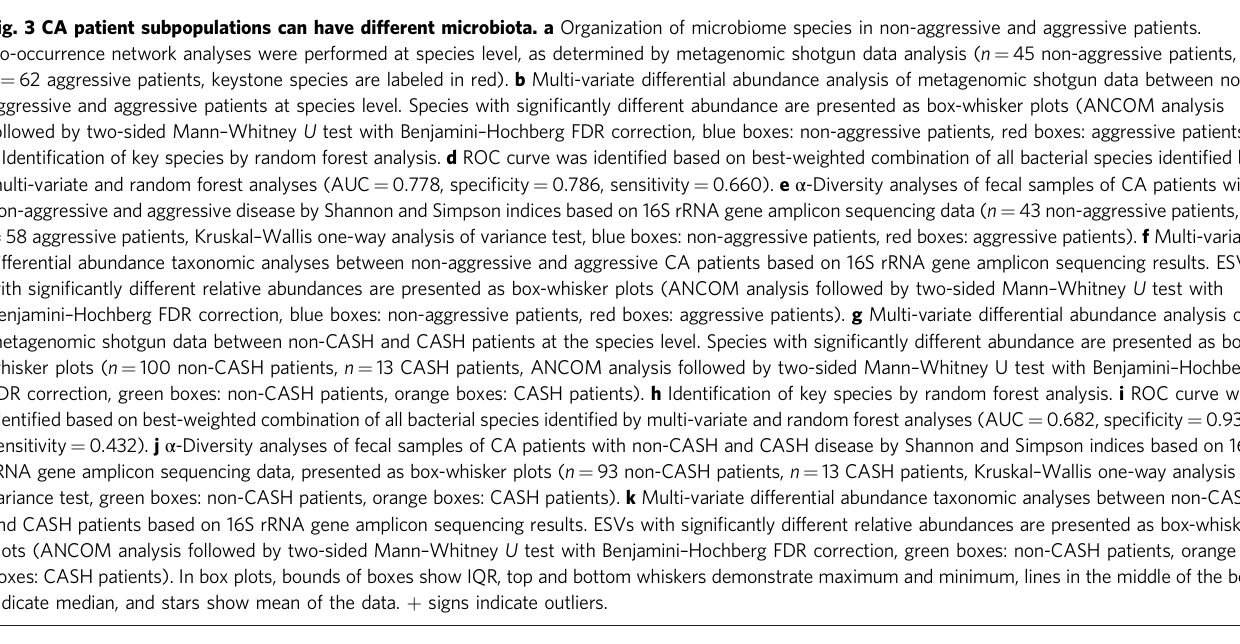
Fig. 3 CA patient subpopulations can have different microbiota. a Organization of microbiome species in non-aggressive and aggressive patients. Co-occurrence network analyses were performed at species level, as determined by metagenomic shotgun data analysis ( n = 45 non-aggressive patients, n = 62 aggressive patients, keystone species are labeled in red). b Multi-variate differential abundance analysis of metagenomic shotgun data between non- aggressive and aggressive patients at species level. Species with signi fi cantly different abundance are presented as box-whisker plots (ANCOM analysis followed by two-sided Mann – Whitney U test with Benjamini – Hochberg FDR correction, blue boxes: non-aggressive patients, red boxes: aggressive patients). c Identi fi cation of key species by random forest analysis. d ROC curve was identi fi ed based on best-weighted combination of all bacterial species identi fi ed by multi-variate and random forest analyses (AUC = 0.778, speci fi city = 0.786, sensitivity = 0.660). e α -Diversity analyses of fecal samples of CA patients with non-aggressive and aggressive disease by Shannon and Simpson indices based on 16S rRNA gene amplicon sequencing data ( n = 43 non-aggressive patients, n = 58 aggressive patients, Kruskal – Wallis one-way analysis of variance test, blue boxes: non-aggressive patients, red boxes: aggressive patients). f Multi-variate differential abundance taxonomic analyses between non-aggressive and aggressive CA patients based on 16S rRNA gene amplicon sequencing results. ESVs with signi fi cantly different relative abundances are presented as box-whisker plots (ANCOM analysis followed by two-sided Mann – Whitney U test with Benjamini – Hochberg FDR correction, blue boxes: non-aggressive patients, red boxes: aggressive patients). g Multi-variate differential abundance analysis of metagenomic shotgun data between non-CASH and CASH patients at the species level. Species with signi fi cantly different abundance are presented as box- whisker plots ( n = 100 non-CASH patients, n = 13 CASH patients, ANCOM analysis followed by two-sided Mann – Whitney U test with Benjamini – Hochberg FDR correction, green boxes: non-CASH patients, orange boxes: CASH patients). h Identi fi cation of key species by random forest analysis. i ROC curve was identi fi ed based on best-weighted combination of all bacterial species identi fi ed by multi-variate and random forest analyses (AUC = 0.682, speci fi city = 0.933, sensitivity = 0.432). j α -Diversity analyses of fecal samples of CA patients with non-CASH and CASH disease by Shannon and Simpson indices based on 16S rRNA gene amplicon sequencing data, presented as box-whisker plots ( n = 93 non-CASH patients, n = 13 CASH patients, Kruskal – Wallis one-way analysis of variance test, green boxes: non-CASH patients, orange boxes: CASH patients). k Multi-variate differential abundance taxonomic analyses between non-CASH and CASH patients based on 16S rRNA gene amplicon sequencing results. ESVs with signi fi cantly different relative abundances are presented as box-whisker plots (ANCOM analysis followed by two-sided Mann – Whitney U test with Benjamini – Hochberg FDR correction, green boxes: non-CASH patients, orange boxes: CASH patients). In box plots, bounds of boxes show IQR, top and bottom whiskers demonstrate maximum and minimum, lines in the middle of the box indicate median, and stars show mean of the data. + signs indicate